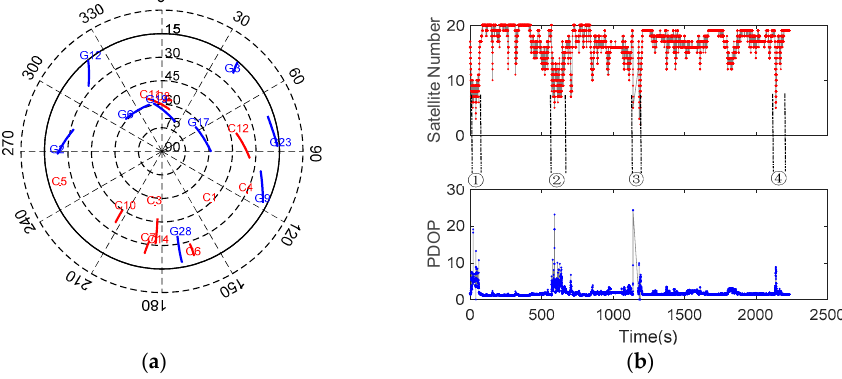
Figure 13. Sky plot ( a ) and the satellite visibility ( b ) for test #2.